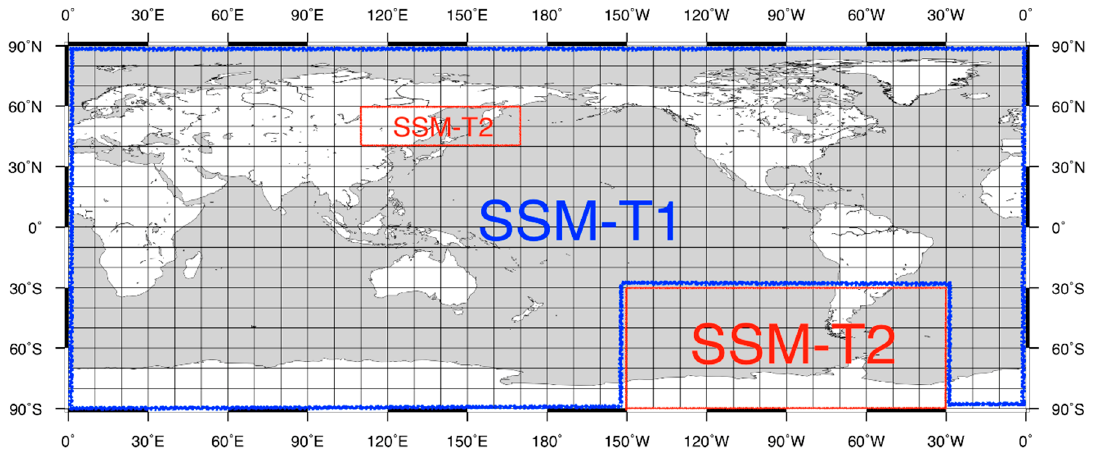
Figure 1. Geographic latitude and longitude range of the SSM-T1 and SSM-T2 for the TECM-GRID.